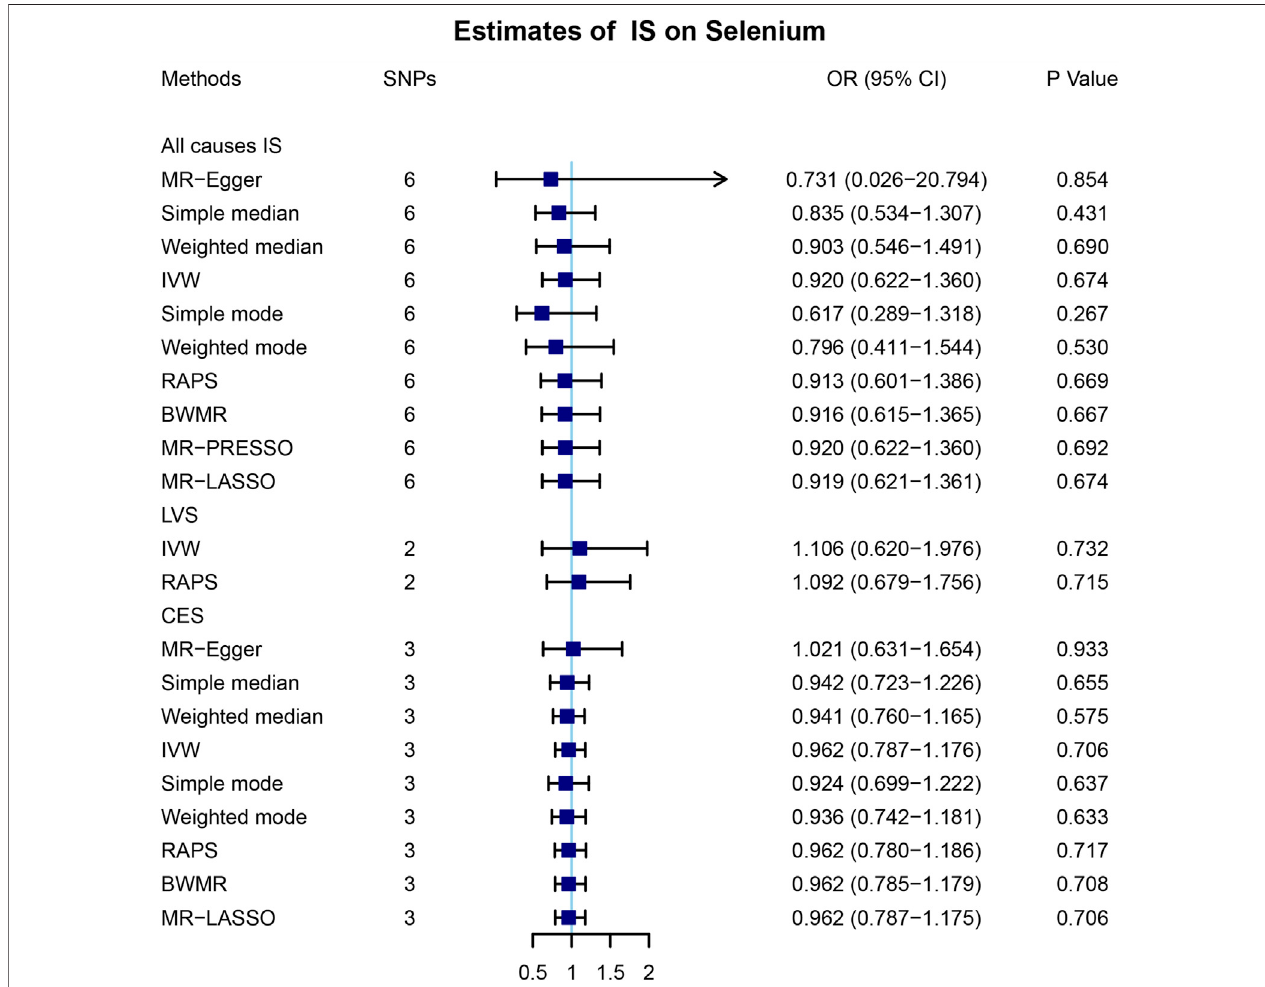
FIGURE 3| Mendelian randomization analysis of the causal effects ofischemic stroke on blood selenium levels. Atotal of6, 2, and 3 SNPs signi fi cantly associated with IS of all causes, LVS, and CES were obtained in the reverse Mendelian randomization analysis. MR, Mendelian randomization; IS, ischemic stroke; SNP, single- nucleotide polymorphism; OR, odds ratio; CI, con fi dential interval; IVW, inverse variance-weighted; RAPS, robust adjusted pro fi le score; BWMR, Bayesian weighted Mendelian randomization; MR-PRESSO, Mendelian randomization pleiotropy residual sum and outlier; MR-LASSO, Mendelian randomization least absolute shrinkage and selection operator; LVS, large-vessel atherosclerosis stroke; CES, cardio-embolic stroke; SVS, small-vessel occlusion stroke.